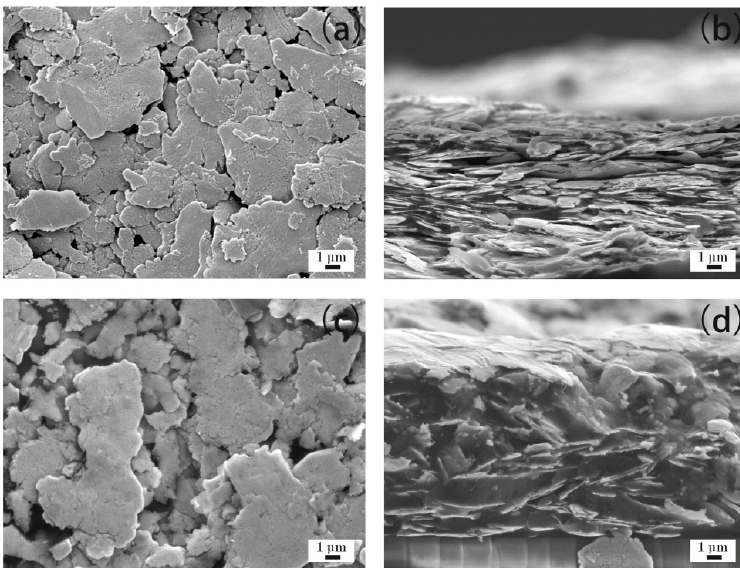
Figure 9. ECAs filled with 70 wt % Ag flakes. ( a ) ECAs fabricated by the powder spraying process; and ( b ) cross sections of ECAs fabricated by the powder spraying process; ( c ) ECAs fabricated by the conventional process; and ( d ) cross sections of ECAs fabricated by the conventional process.